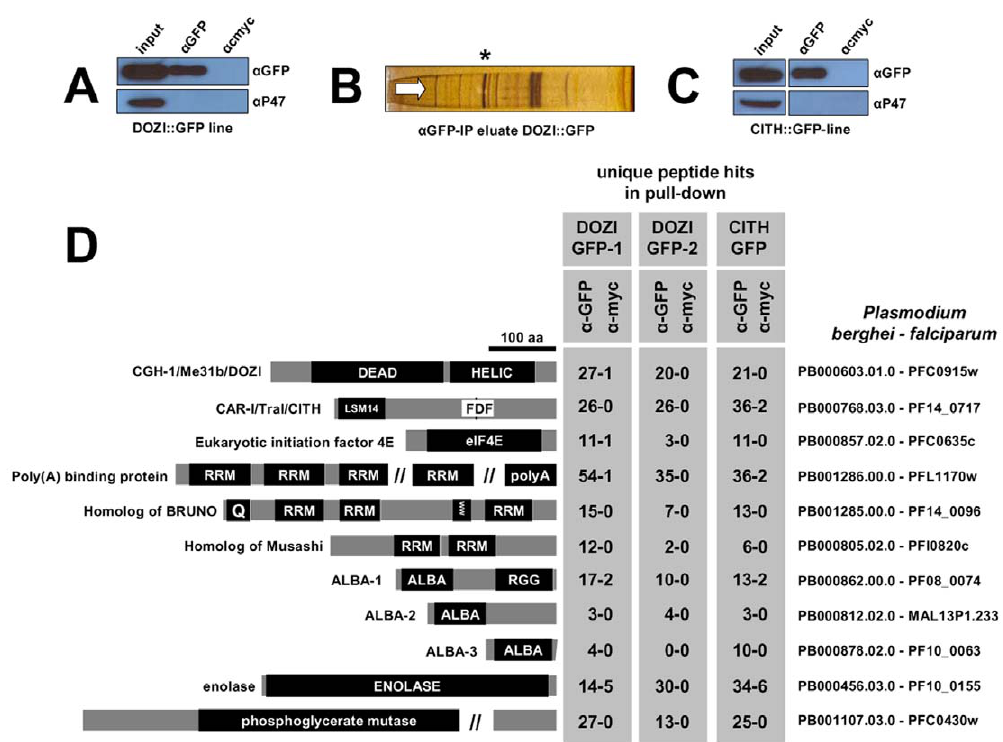
Figure 1. Identification of a multiprotein complex engaged in storage of translationally silent mRNAs in female Plasmodium gametocytes. A and C Western blot analysis of DOZI and CITH immunoprecipitation (IP) eluates show specific isolation of the respective GFP fusion proteins. P47, a female gametocyte specific protein, did not co-IP and is present only in input fractions. Equivalent amounts were loaded. B Silver staining of the DOZI::GFP IP eluate separated on a 12% SDS-PAGE. The asterisk indicates the position/size of the DOZI::GFP fusion protein. D Reciprocal IP targeting C-terminal GFP-fusion proteins of DOZI and CITH resulted in the pull down of a set of proteins that were identified using LC- MS/MS. Shown are all proteins with conserved motifs (drawn to scale) and – grey underlaid – the number of unique peptide hits/protein in specific anti-GFP and control IPs. Alignments of these factors and additional Plasmodium -specific factors are shown in Table S1, Figures S1, S4, S5, S6, S7, S8, S9 and S10. Homology was defined on amino acid level, as well as domain presence and